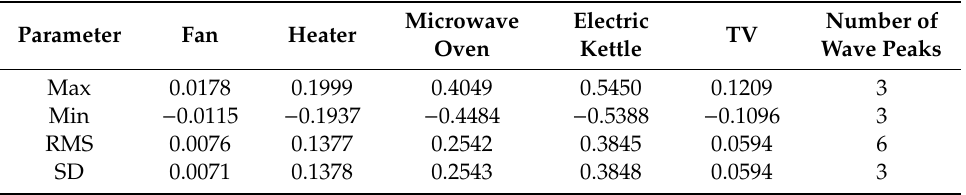
Figure 3. Waveform and characteristic values of the steady-state load current of some types of household appliances. Table 1. Characteristic values of the steady-state operation.